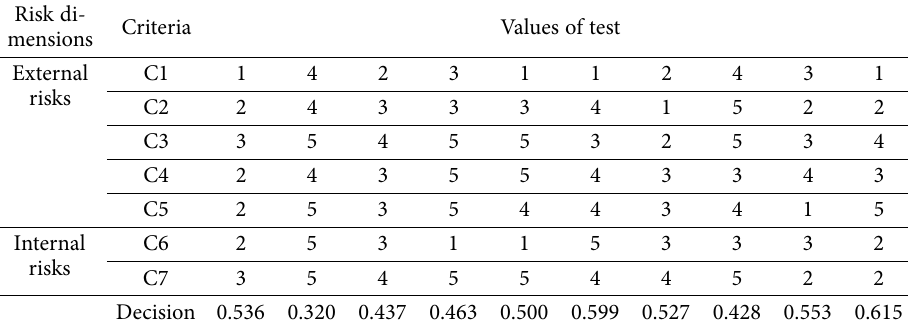
Values of testCriteria